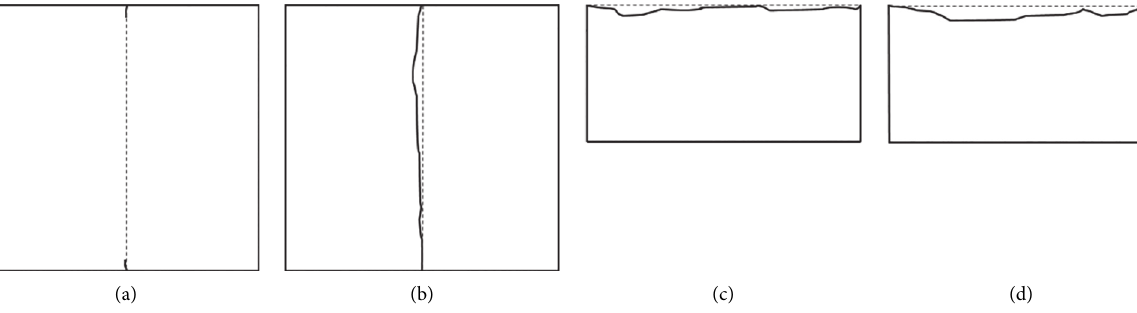
Figure 6: Splitting failure modes of concrete at different stages. (a) Initial failure mode, (b) final failure mode, (c) 0% failure section, and (d) 40% failure